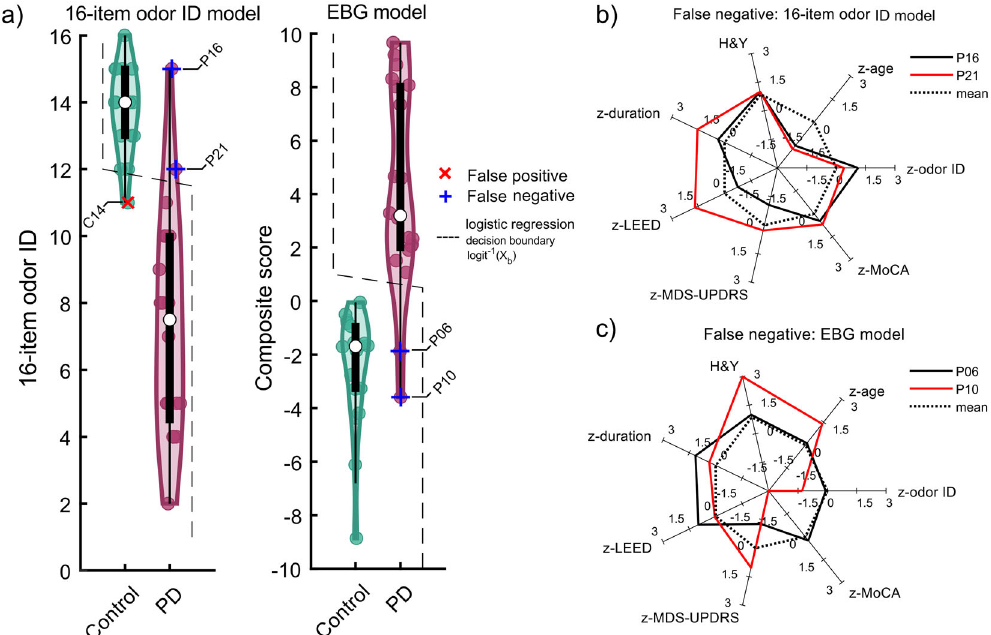
Fig. 3 The logistic regression decision boundary. a Violin plot shows the distribution for 16-item odor ID responses and EBG responses. The scatter plot within the distribution shows individual responses. The black box shows the 25 and 75 percentiles in which the white dot shows the median. The whiskers show the maximum and minimum within 1.5 times of the interquartile range. The logistic decision boundary is shown with the dashed line. b Radar plot shows the demographic and PD parameters for the false negatives that occurred in the 16-item odor ID model. c Similarly, the radar plot shows the demographic and PD parameters for the false negatives that occurred in the EBG model. The dashed line in ( b ) and ( c ) shows the mean response. Note, all the false negatives had an available MDS-UPDRS